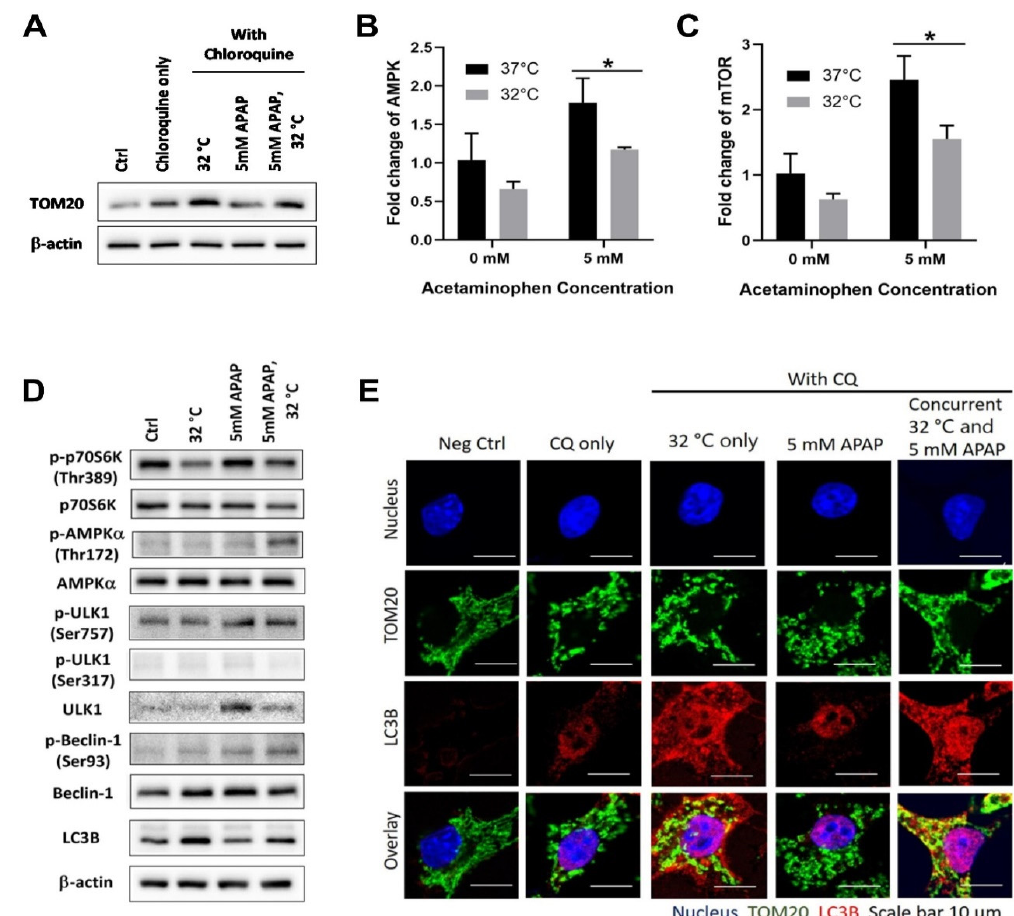
Figure 1. E ff ect of moderate hypothermia (32 ◦ C) on the extent of mitophagy in transgenic mouse hepatocytes (TAMH). ( A ) Western blotting of microtubule-associated proteins 1A / 1B light chain 3B (LC3B) and translocase of outer mitochondrial membrane 20 (TOM20) were performed in the presence of 80 µ M chloroquine (CQ), to demonstrate the e ff ect of hypothermia on mitophagy. Western blot for LC3B has been merged to show the relevant bands at the specified sample conditions. Next, quantitative analysis with real time reverse transcriptase-polymerase chain reaction (RT-PCR) was performed to determine the transcript expressions of ( B ) AMP-activated protein kinase (AMPK) and ( C ) mechanistic target of rapamycin (mTOR) while ( D ) western blotting was used to determine the protein expressions of ribosomal protein S6 kinase B1 (p70S6K), phosphorylated-p70S6K (p-p70S6K), AMPK α , phosphorylated-AMPK α (p-AMPK α ), unc-51-like autophagy activating kinase 1(ULK1), phosphorylated-ULK1 (p-ULK1), Beclin-1 and phosphorylated-Beclin-1 (p-Beclin-1). ( E ) Immunofluorescence imaging of TOM20 and LC3B was carried out in the presence of 80 µ M CQ. β -actin was used as the housekeeping protein for all western blots. Data are presented as mean ± SD ( n = 3), where an unpaired t-test was used to compare the e ff ect of hypothermia on TAMH against their respective controls treated with the same acetaminophen (APAP) dose. Scale bar = 40 µ m. * p <